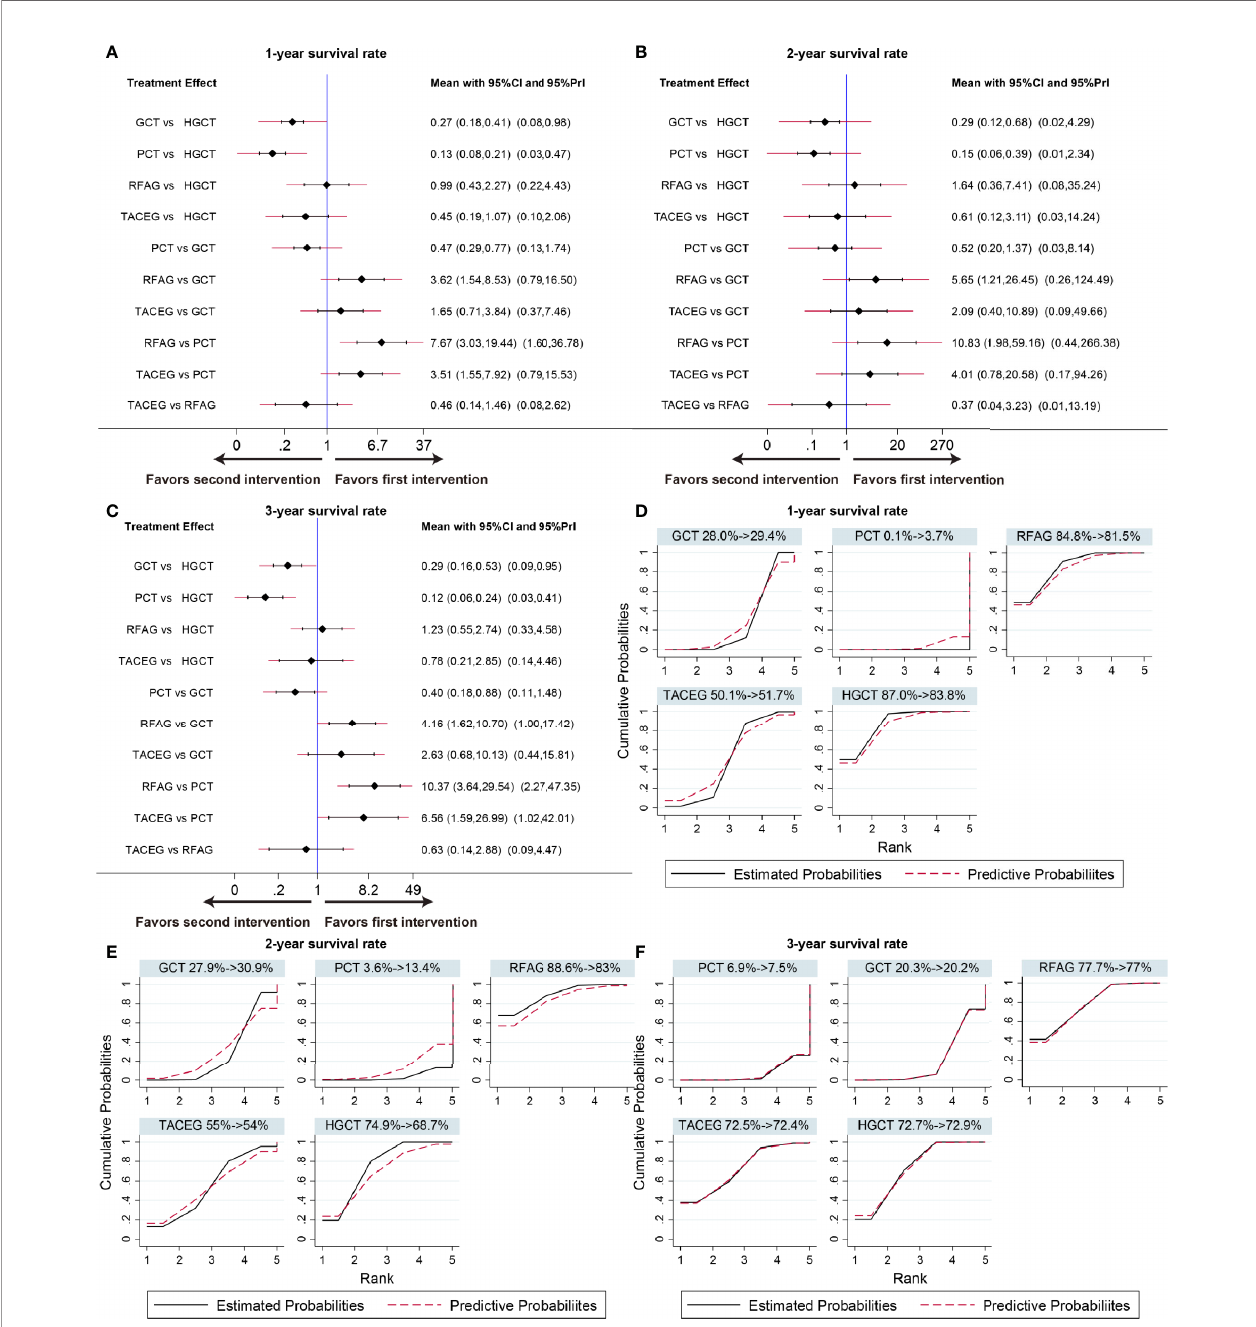
FIGURE 4 | Con fi dence interval plot and SUCRA for the network analysis. The black and red solid lines represent the 95% con fi dence interval and the predictive intervals for summary relative risks for each comparison in the con fi dence interval plot. The blue line is the line of no effect (relative risk equal to 1). Con fi dence interval plot of 1-, 2- and 3- year survival rate (A – C) . SUCRA of 1-, 2- and 3- year survival rate (D – F) . Black solid lines correspond to the unadjusted model and red dashed lines to the adjusted for small effects model. Ranking indicates the probability to be the best